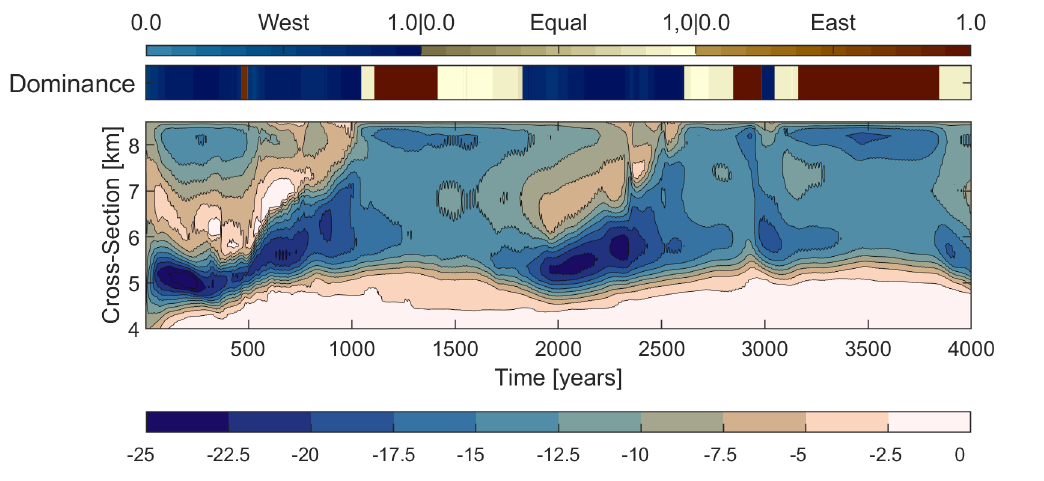
Figure 7. Depth of the investigated cross-section over time, showing the alternation of the two-channel system. The channel dominance calculated by the CASE method is displayed above, greenish colors indicating western dominance, reddish colors indicating eastern dominance and brownish indicating a balanced two-channel system, the shading within each color indicating the strength of the